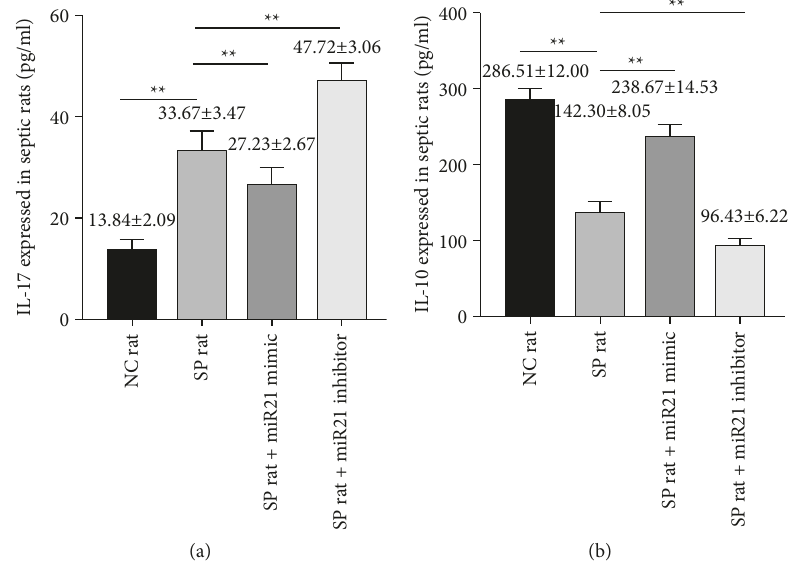
Figure 8: The levels of IL-17 and IL-10 in peripheral blood were changed after transfection of miR-21 activator or inhibitor into lymphocytes of septic rats. ((a) and (b)) The levels of IL-17 and IL-10 in peripheral blood in eight-paired NC rat group, SP rat group, SP rat +miR21 mimic group, and SP rat+ miR21 inhibitor group were determined by ELISA [ t value (IL-17: NC versus SP) � 13.660, p < 0.01; t value (IL-17: miR- 21 mimic versus SP) � 5.096, p < 0.01; t value (IL-17: miR-21 inhibitor versus SP) � 8.638, p < 0.01; t value (IL-10: NC versus SP) � 29.703, p < 0.01; t value (IL-10: miR-21 mimic versus SP) � 18.042, p < 0.01; t value (IL-10: miR-21 inhibitor versus SP) � 14.523, p < 0.05]. NC group: normal control group; SP group: sepsis group; SP rat +miR21 mimic group: sepsis group with miR-21 activator transfected into lymphocytes; SP rat +miR21 inhibitor group: sepsis group with miR-21 inhibitor transfected into lymphocytes. ∗∗ p <